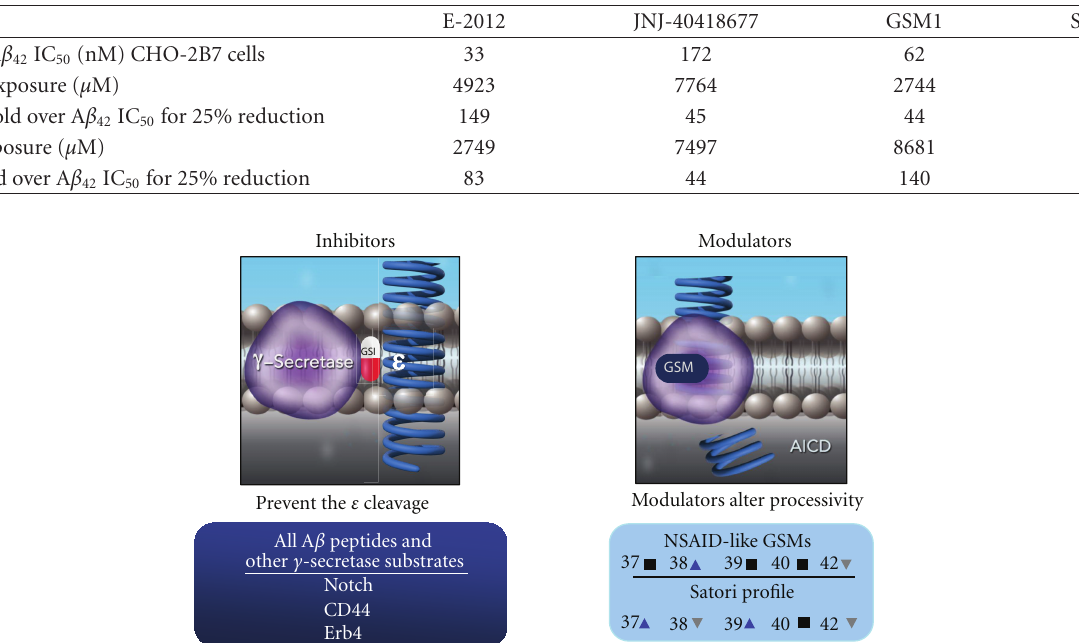
Table 2: GSM potency versus plasma exposure in mice.